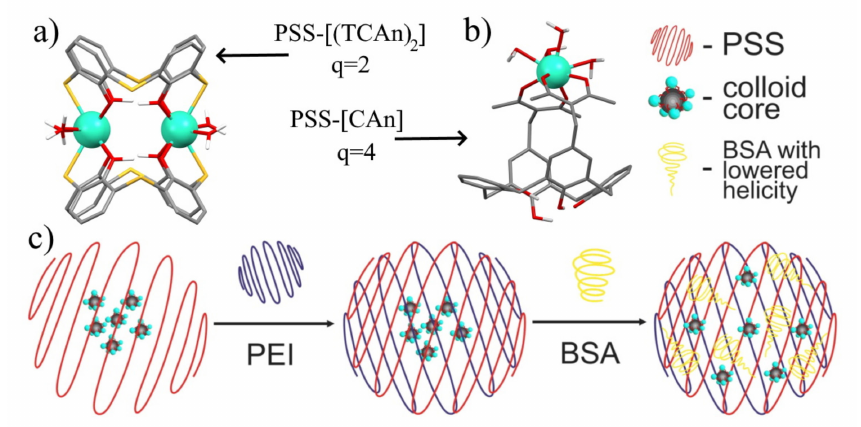
Figure 16. Schematic presentation of the coordination modes of Ln 3+ ions in ( a ) [Ln 2 (TCAi) 2 ] (TCAi = 34, 42 ) and ( b ) [LnCAi] (Cai = 32a , 32b , 37 ) complexes and their corresponding hydration numbers, q. ( c ) Schematic presentation of PSS-Na[Gd 2 26 ], PEI-PSS-Na[Gd 2 26 ], and BSA-PEI-PSS- Na[Gd 2 26 ] colloids. Reproduced from Refs. [109,113] with permission from the Elsevier.